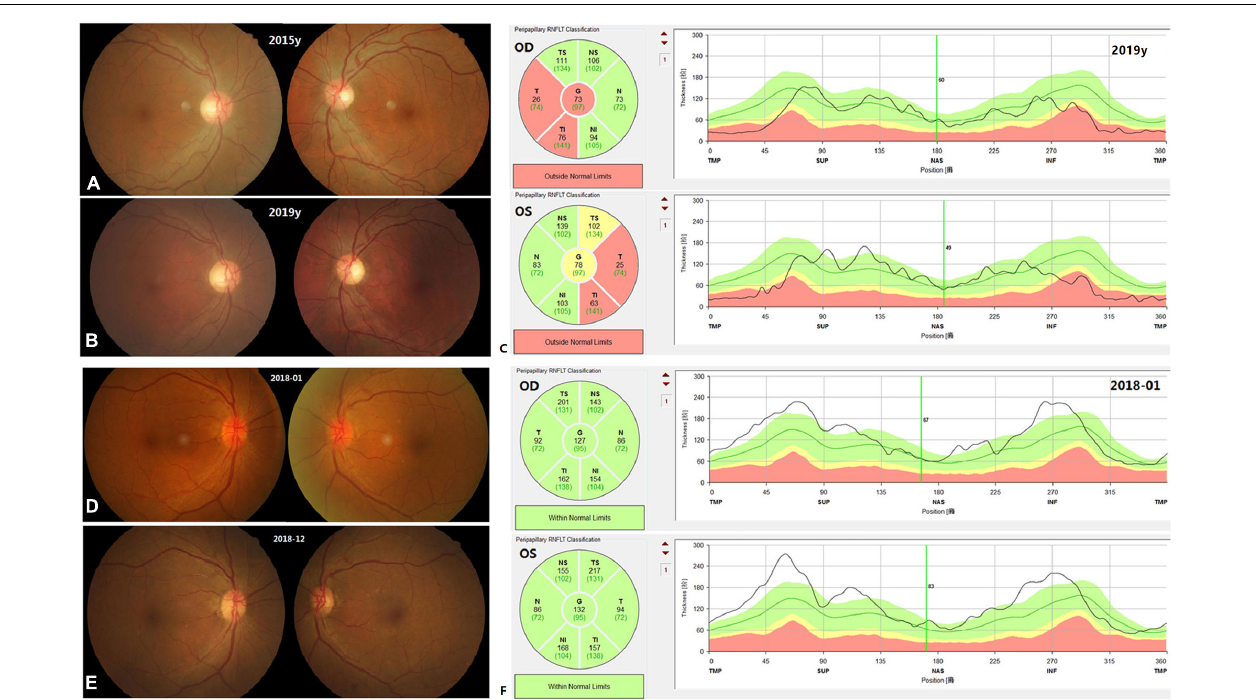
FIGURE 3 | Fundus appearance and OCT images on the first visit and at follow-up for patient E005 (A–C) and patient A3124 (D–F) . In the patient E005, the fundus appearance did not change. The temporal RNFL in both eyes was below the normal limits at follow-up (C) . In the patient A3124, the color and border of the optic discs turned normal. The RNFL was thickened in both eyes on the first visit (F) .